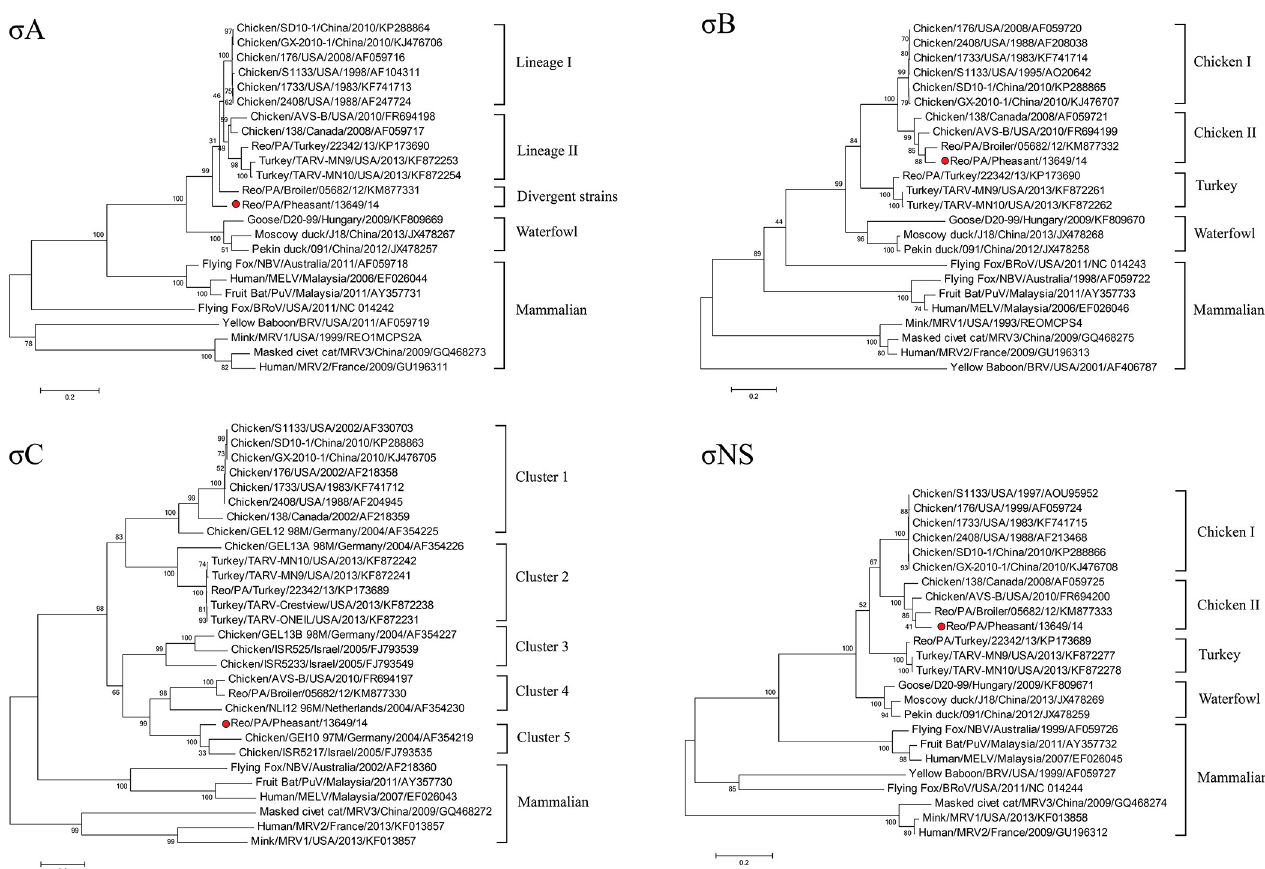
Fig 4. The mVISTA method for whole genome nucleotide alignment. Alignment result of the Reo/SDWF /Pheasant/17608/20 in comparisons with the Reo/ PA/Broiler/05682/12 (or PA05682), S1133, 1733, 138, Reo/PA/Turkey/22342/13 (or PA22342) and J18 strains was illustrated; Areas in pink color represent � 90% similarities; and areas in white represent < 90% similarities. The scale bar measures approximate length of the concatenated genome.